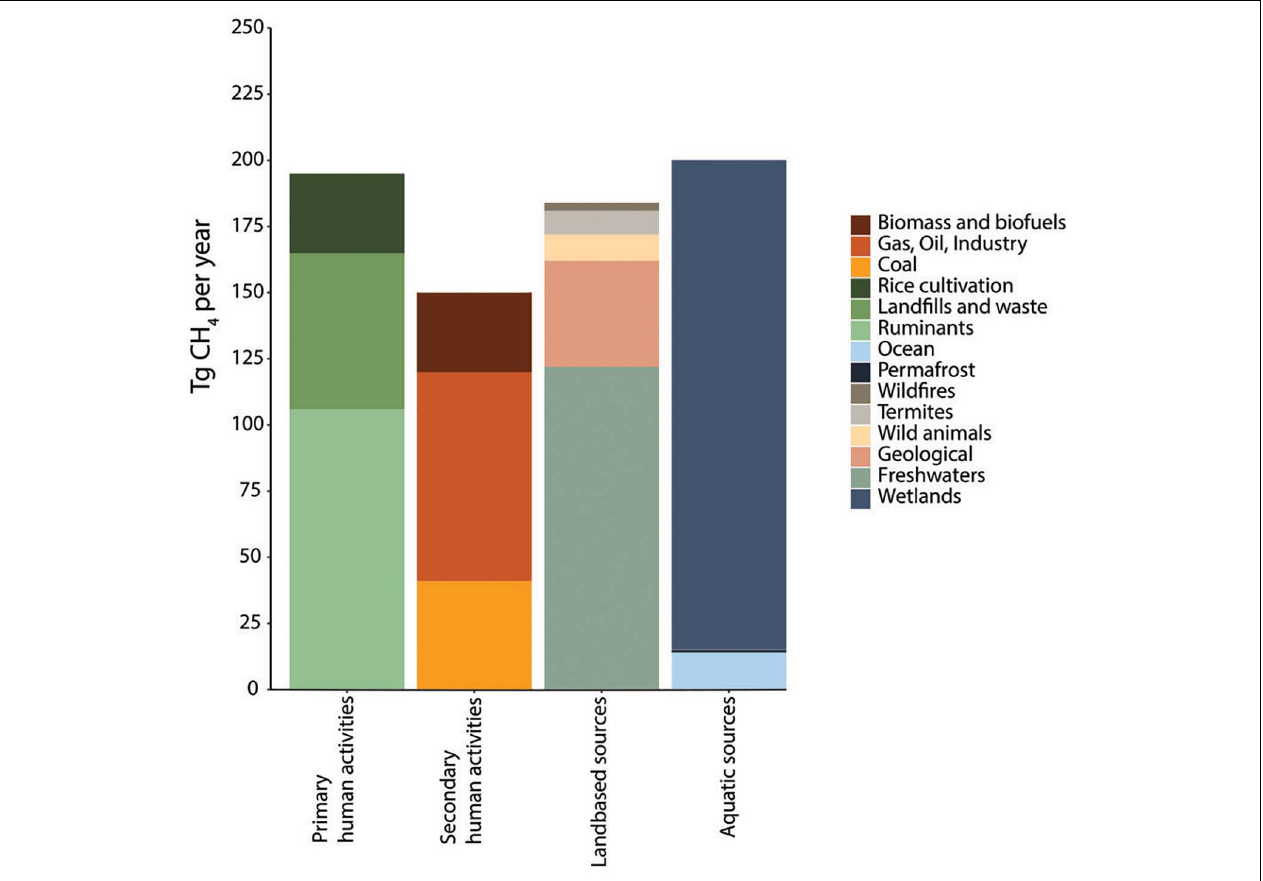
FIGURE 1 | Methane emissions from 2008 to 2017, using a bottom-up approach (based on Saunois et al., 2020). Only average values are shown. The category “Human primary activities” is the focus of this review, methanotrophs receive special attention in wastewater treatment regarding their potential to mitigate GHG emissions and valorization of waste (Sections “Fate of Methane and Application Potential of Anaerobic Methanotrophs in Wastewater Treatment” and “Applications of Aerobic Methanotrophs in a Circular Economy”).